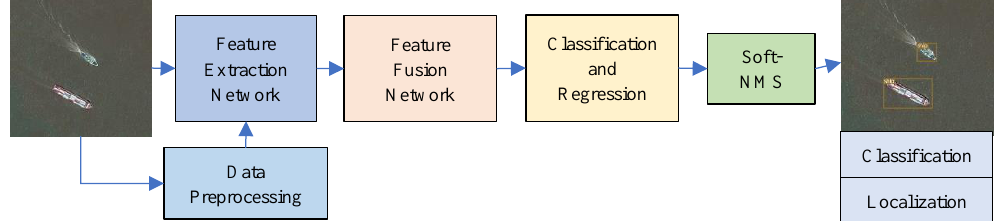
Figure 1. Flow chart of the proposed ship detection network-based convolutional feature fusion (CFF-SDN). The object detection framework consists of a feature extraction network, a feature fusion network, classification and regression. The detection result contains the classification and localization of ship s .